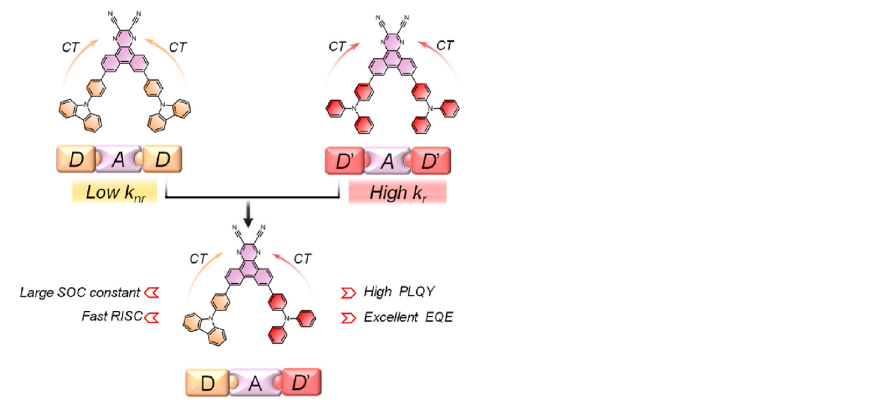
Figure 18. Molecular design strategy and chemical structures of M51 (adapted from ref. [38]).